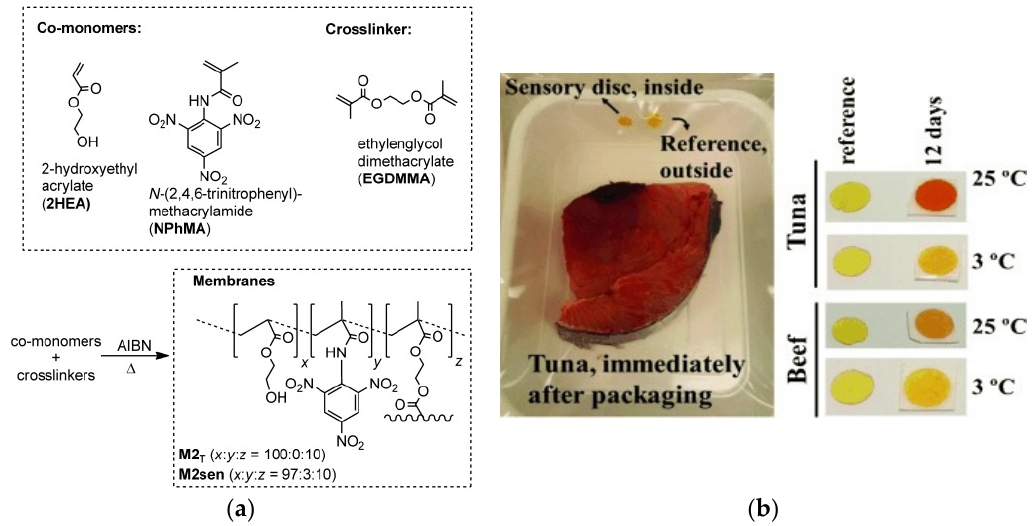
Figure 4. Determination of biogenic amines in tuna using acrylic polymers: ( a ) monomers and chemical structure of the sensory membrane and the ( b ) color development of the sensory polymers inside tray-packaged tuna under different ambient conditions. Adapted with permission from [67].